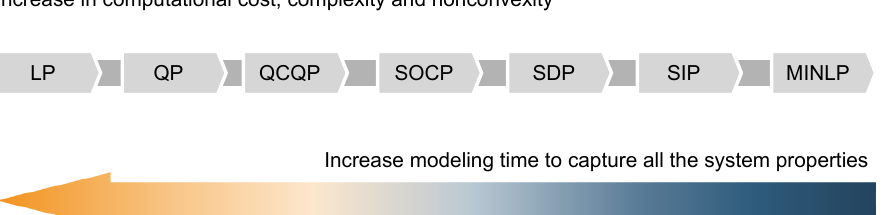
Figure 23. Trade off between reduced order modeling efforts and the solver computational cost. To implement MPC for a specific ICE problem, both the method and solver must